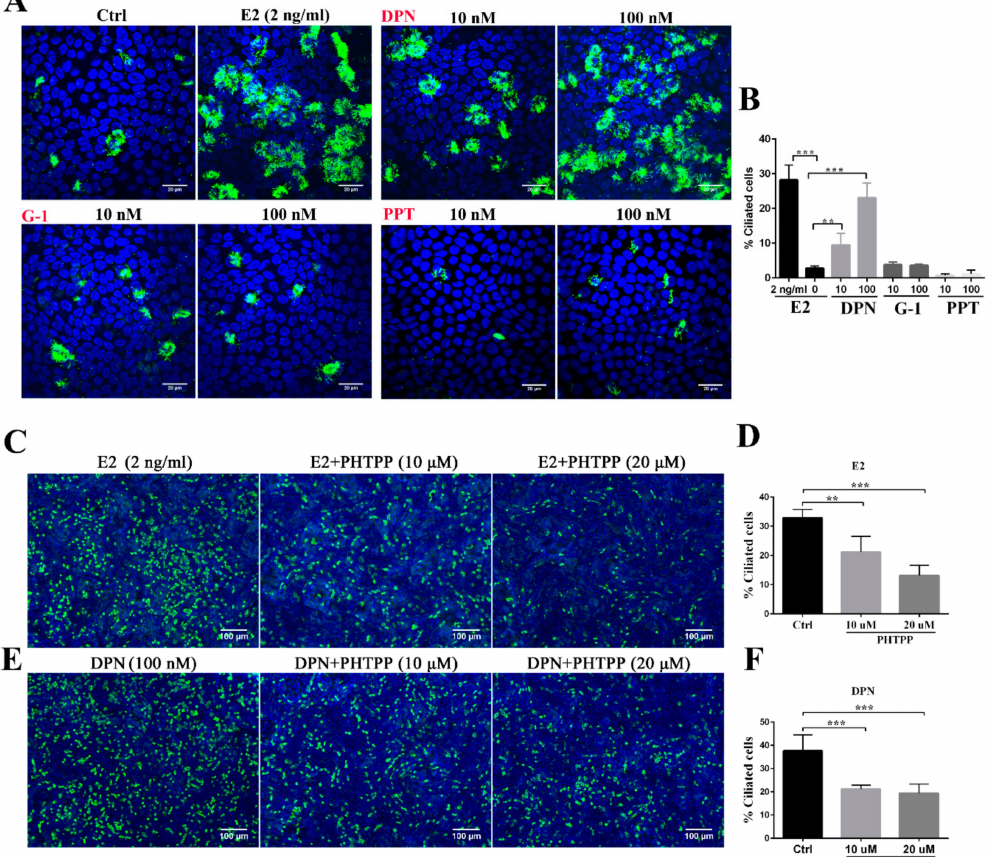
Figure 2. E2 promotes ciliogenesis through ER β . ( A ) FTECs were incubated in the absence (Ctrl) and presence of E2, DPN, PPT and G-1. Cells on ALI day 15 were stained for ac-tubulin (green) and nuclei (blue). Scale bars: 20 µ m. ( B ) The numbers of ac-tubulin-positive cells in A were quantified (ANOVA test, n = 5). ( C – F ) FTECs were cultured with E2 or DPN and with or without PHTPP. Cells on ALI day 15 were stained for ac-tubulin (green) and nuclei (blue). ( C , E ) The numbers of ac-tubulin-positive cells were quantified ( D , F ; ANOVA test, n = 5). Scale bars: 100 µ m. Significance level: ** p < 0.01, and *** p <